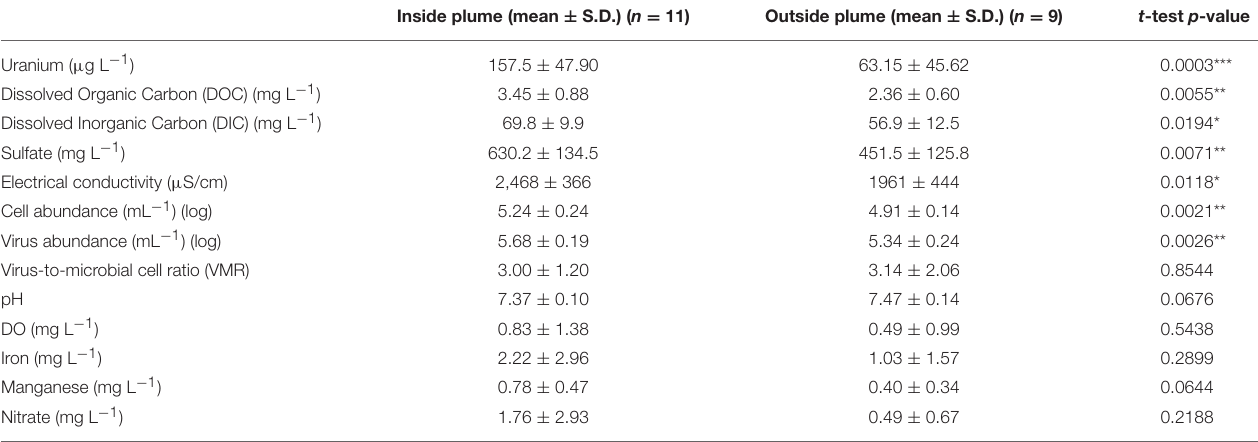
TABLE 1 | Comparison of biotic and geochemical parameters in samples collected from monitoring wells located inside and outside of the contaminant plume. Inside plume (mean ± S.D.) ( n =